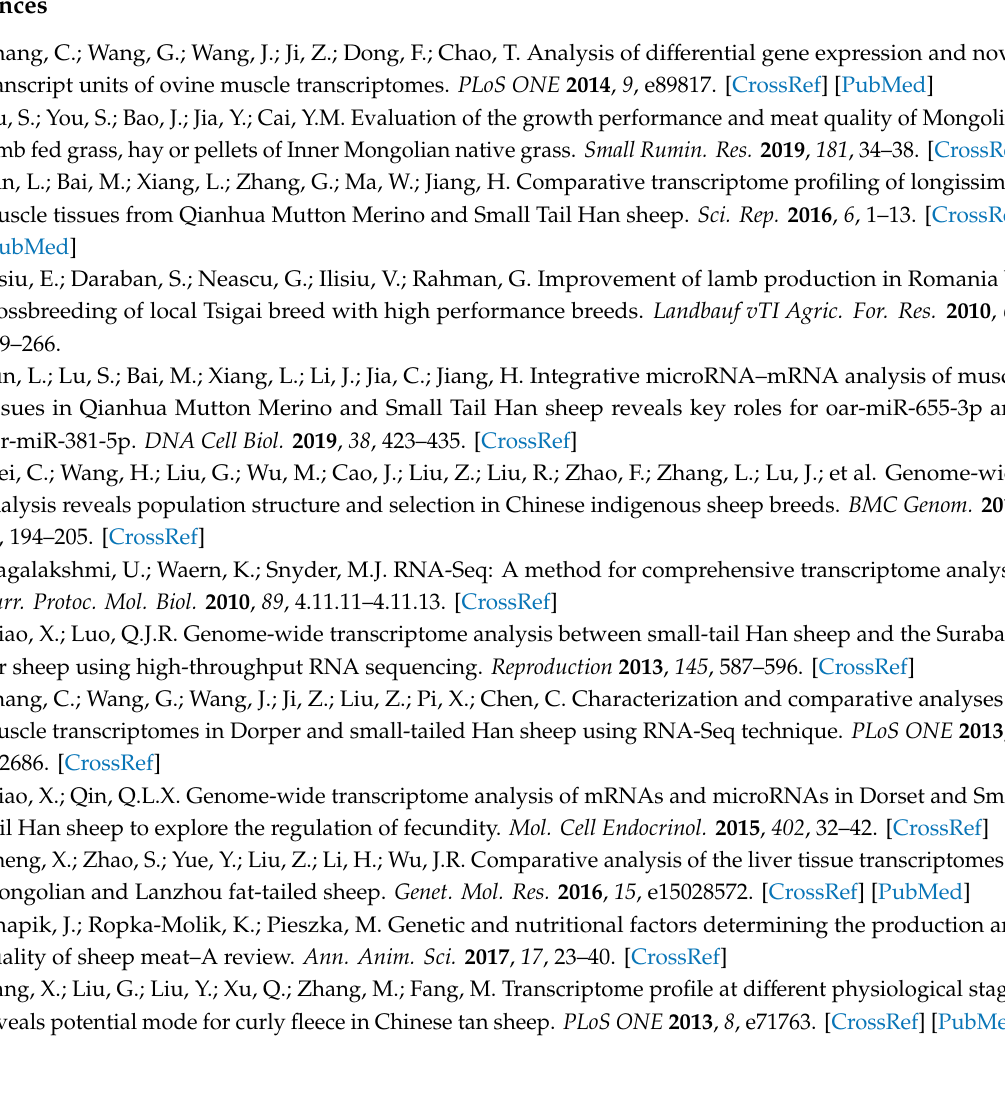
Table S1: Ingredients and nutrition level of the experimental dietary formula; Table S2: qPCR primer sequences; Table S3: Di ff erences in production performance and meat quality between the MG × STH and STH sheep; Table S4: Summary of transcriptomic sequence read mapping in sheep genome V1.0; Table S5: DEGs of the comparative transcriptome analysis in the MG × STH and STH sheep; Table S6: DEGs related to production performance and meat quality in the MG × STH and STH sheep; Table S7: a correlation analysis of multiple traits and traits associated with DEGs in the two types of